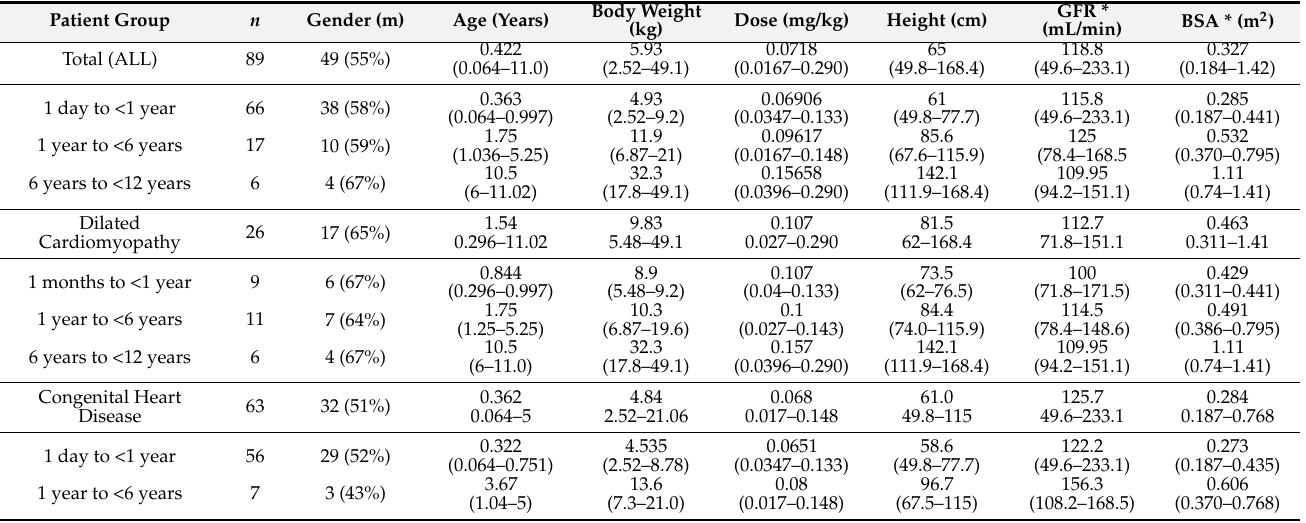
Table 1. Demographics and body weight normalized dose in the pediatric population with heart failure due to dilated cardiomyopathy and congestive heart